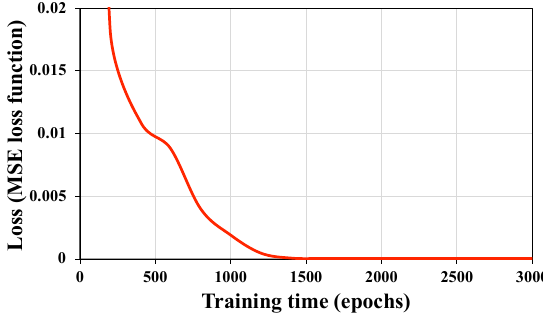
Figure 12. Training loss with time